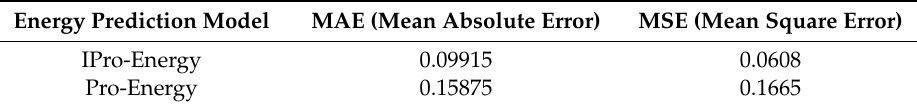
Figure 1. Illustration of a four-day comparative analysis of IPro-Energy with Pro-Energy. Table 1. Prediction error in terms of MAE and MSE for IPro-Energy and